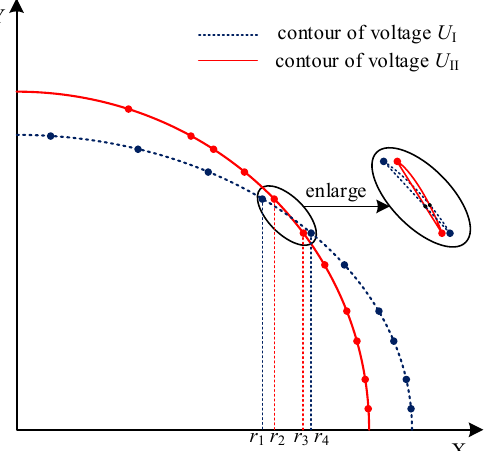
Figure 10. Two contours correspond to the double mutual inductance voltages of 1.819 V ( U I ) and 1.328 V ( U II ) when the inter-axis angle is 20 ◦ .